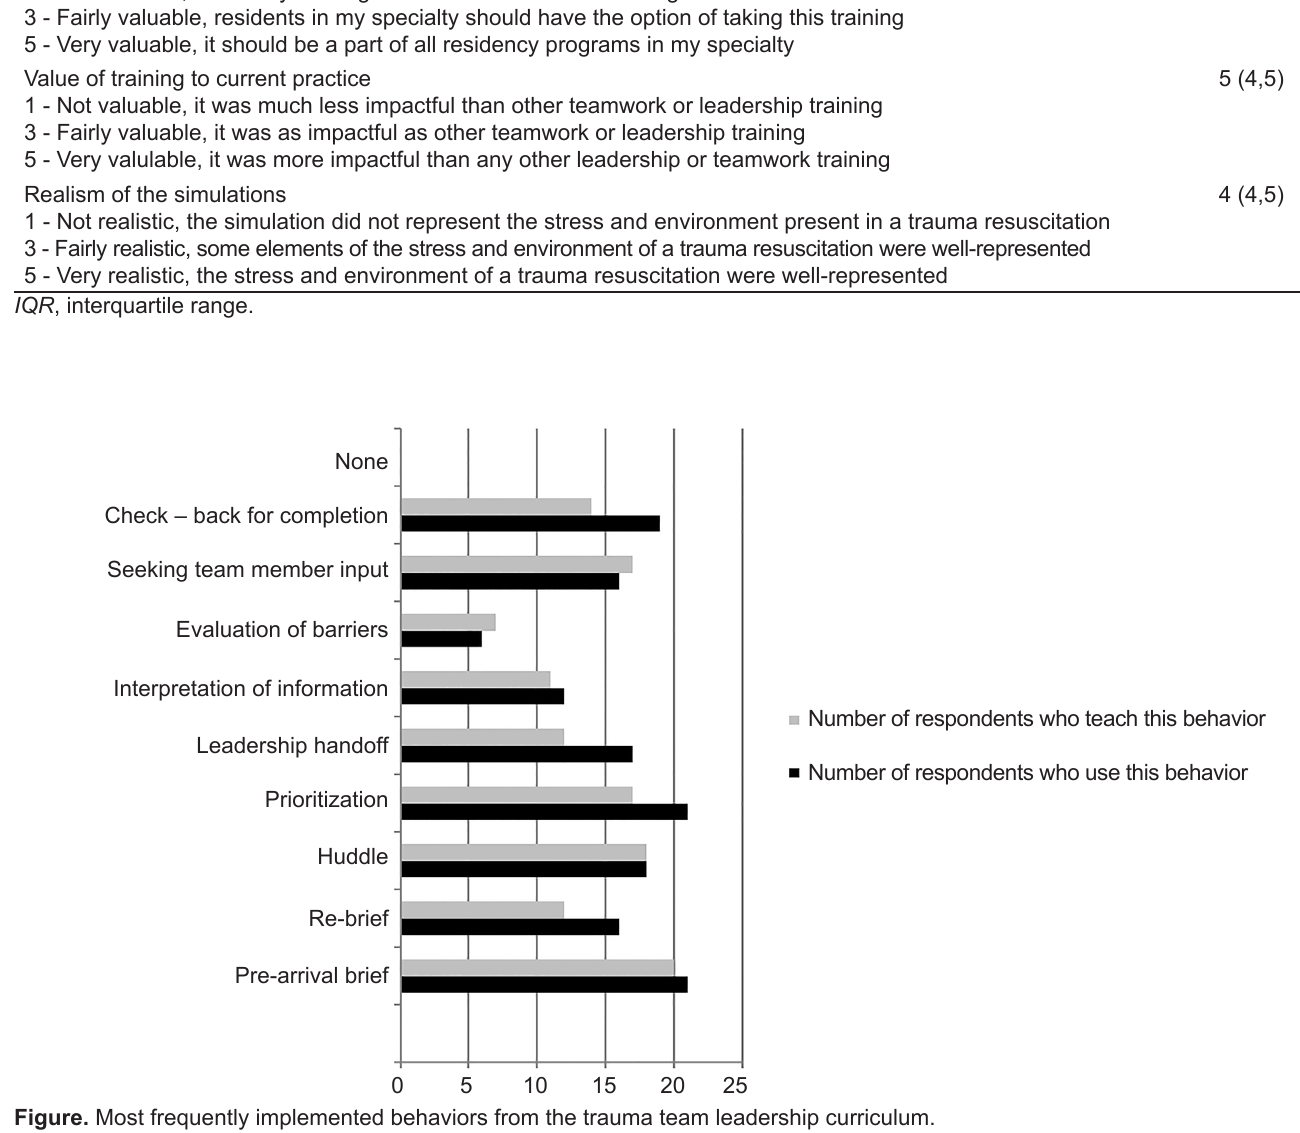
some respondents having completed residency training. Despite